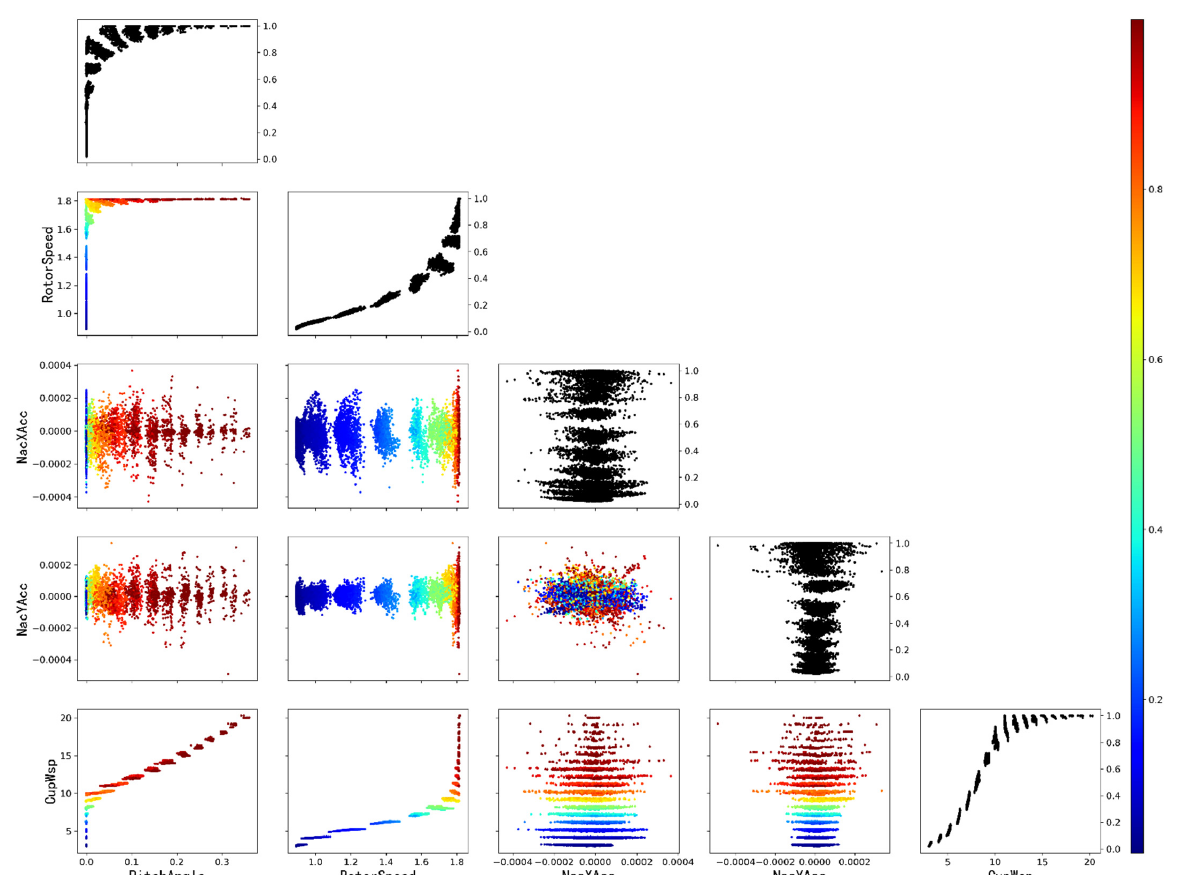
Figure 5. Scatter plot of SCADA data vs. WTG OP, 2D matrix with so-called partial dependence plots of the WTG OP, this shows the influence of each varies from SCADA on the WTG OP. The diagonal shows the effect of a single SCADA parameter (blade pitch angle, rotor speed and nacelle accelerated velocity) on the WTG OP, while the plots below the diagonal show the effect on the WTG OP when varying two dimensions (color axis = normalized power at rated power).